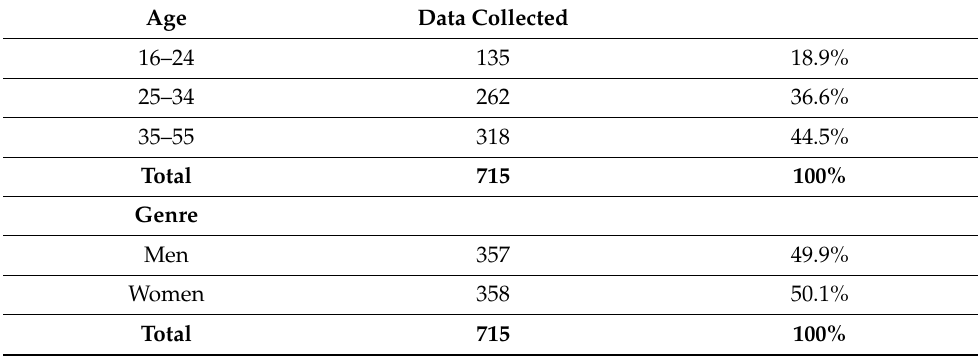
Table 1. Detailed demographics of the